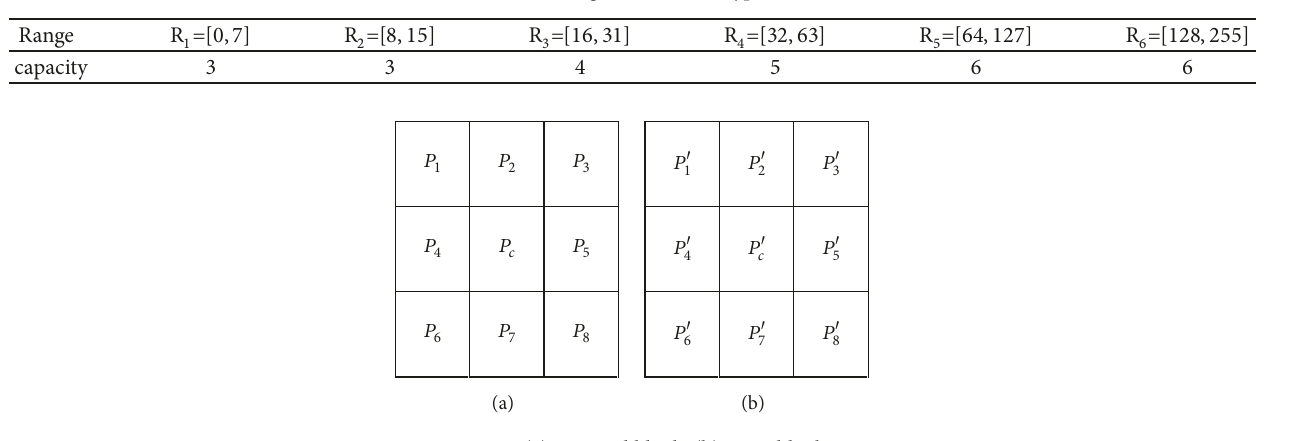
Table 2: Range Table 2 ( for type 2).